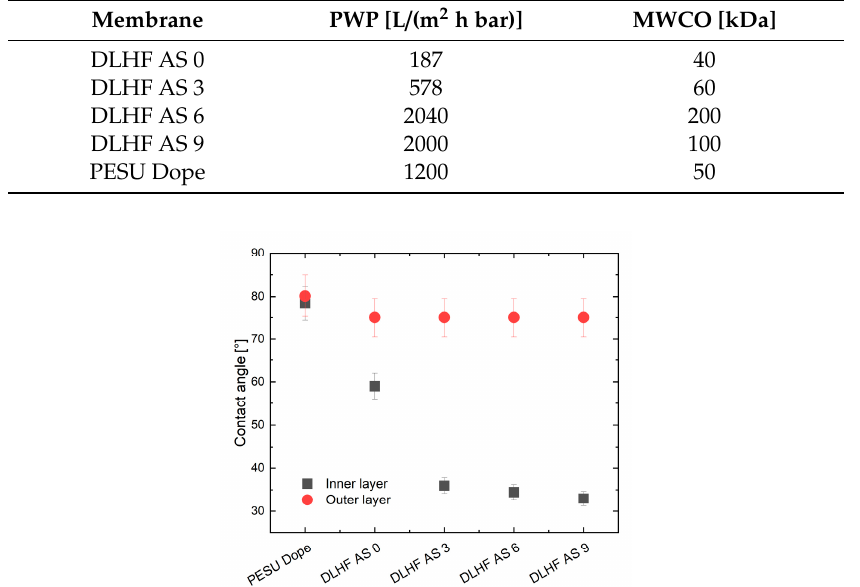
Figure 17. Results of contact angle measurements. Each value is the mean value of five contact angles on different areas of a sample. The hollow fiber membranes were tested on the inside and the outside. For AS 12 only the flat sheet membrane was available, which is why no contact angle value is presented here.